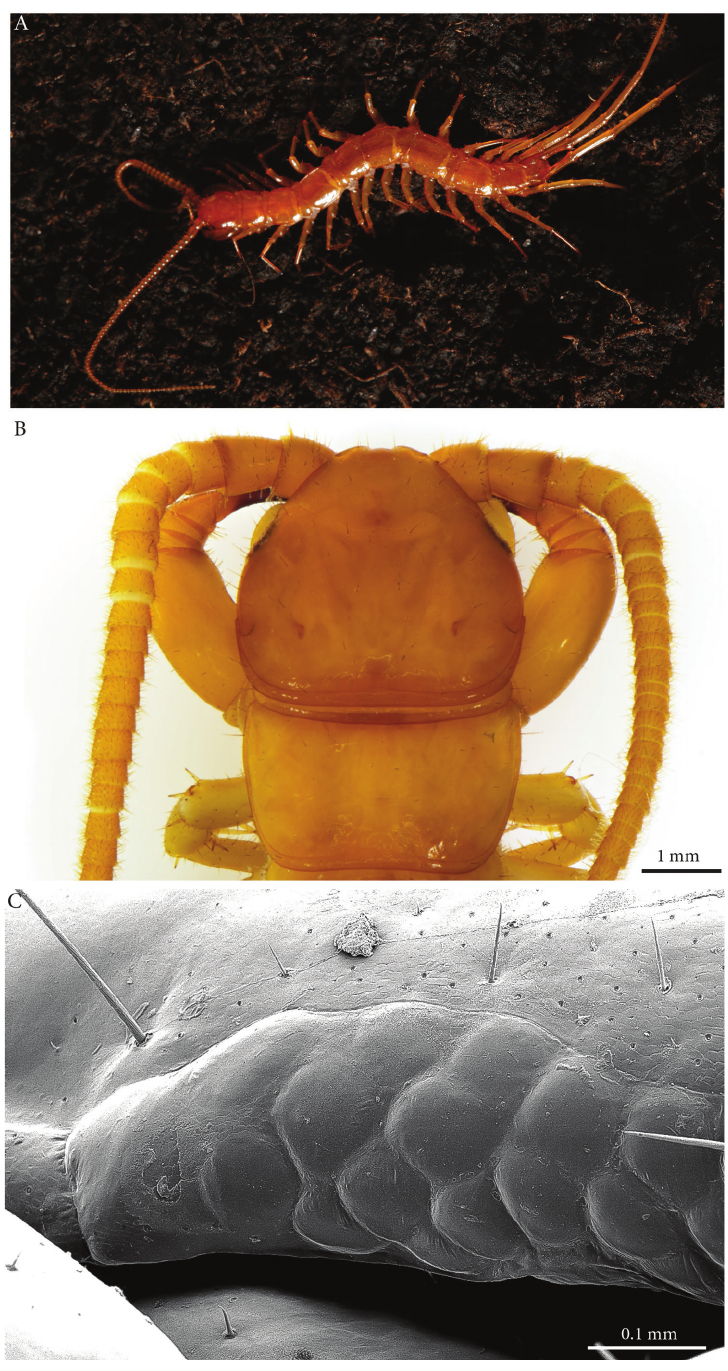
Figure 1. Eupolybothrus liburnicus sp. n. habitus, cephalic plate+T1 and ocelli. A Habitus, holotype B Cephalic plate and T1, holotype, dorsal view C Ocelli, paratype ZMUC